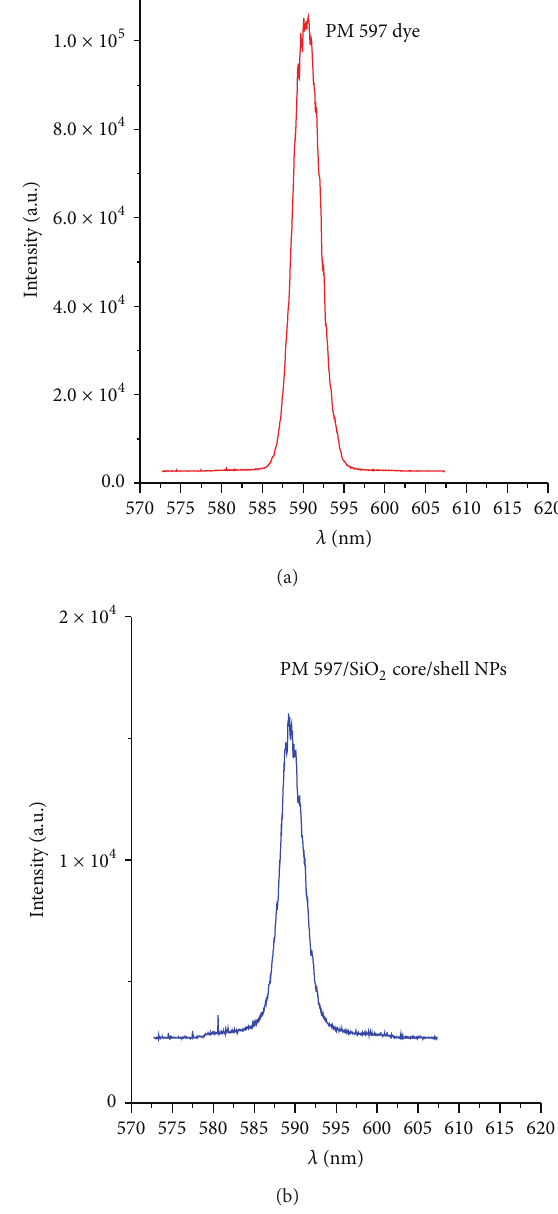
Figure 8: ASE of PM 597 dye and PM 597/SiO 2 core/shell